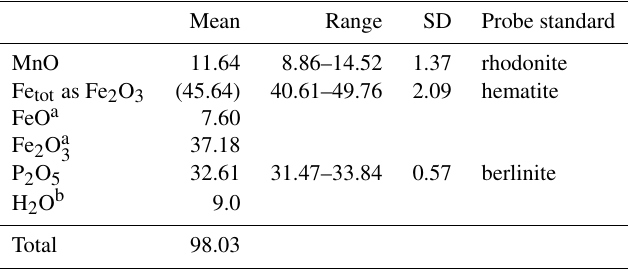
Table 2. Analytical data (wt%) for manganrockbridgeite.